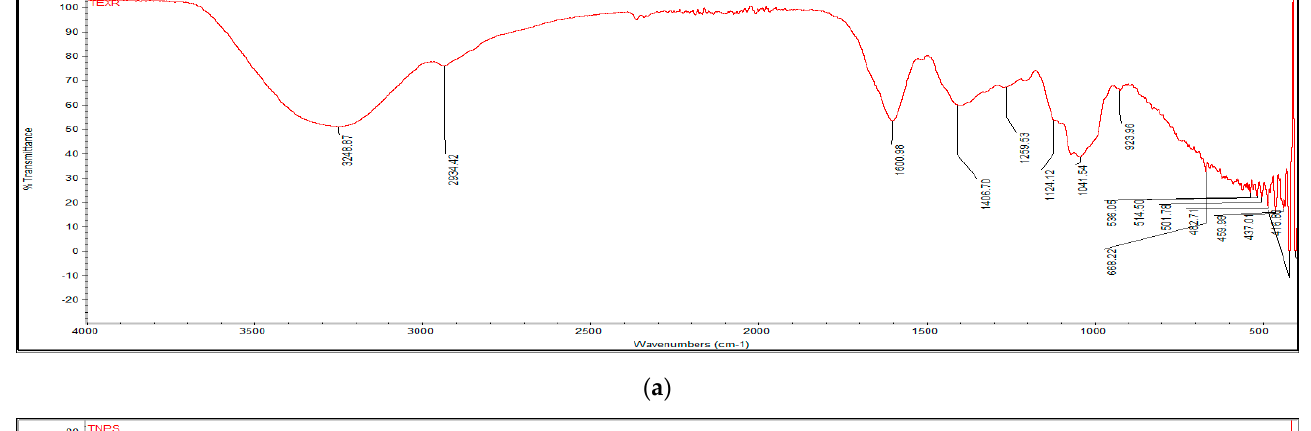
Figure 4. SEM image of T. couneifolia AgNPs. 3.3.5. EDX Analysis The EDX detector linked to the SEM machine was used to determine the elemental composition of the biosynthesized AgNPs (Figure 5). In the graph, a sharp peak at 3 Kev proved that Ag was present, supporting the existence of AgNPs. 41.19 percent Ag was present of the total makeup. As well as C and N and O and Mg and Si and Cl were discovered using EDX investigation.